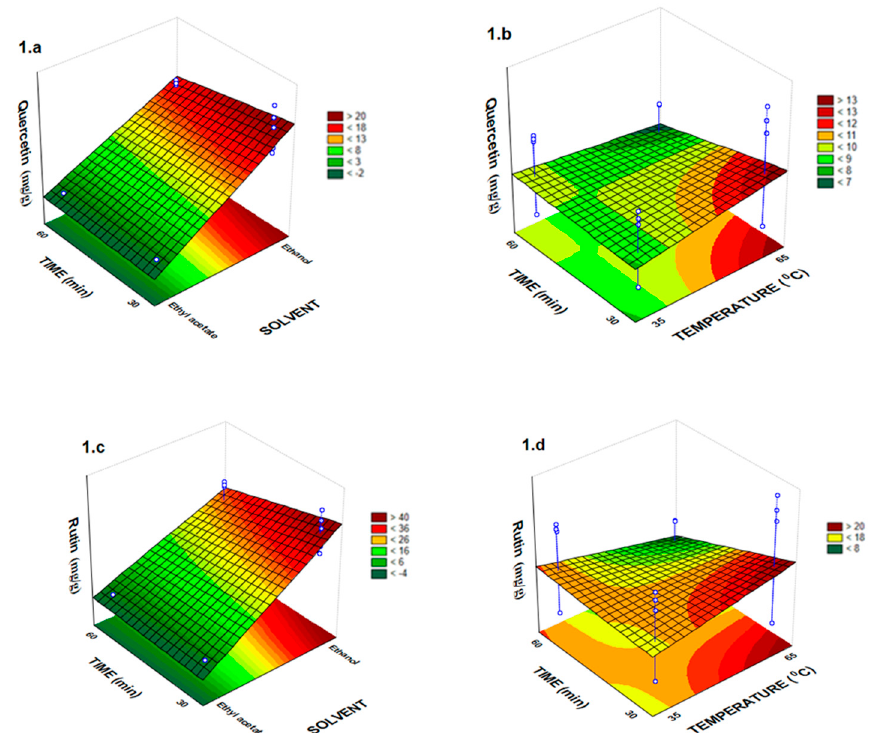
Figure 1. Response surface plots for the effects: time and solvent for the quercetin in ( a ) and rutin in ( c ); time and temperature for the quercetin in ( b ) and rutin in ( d ).